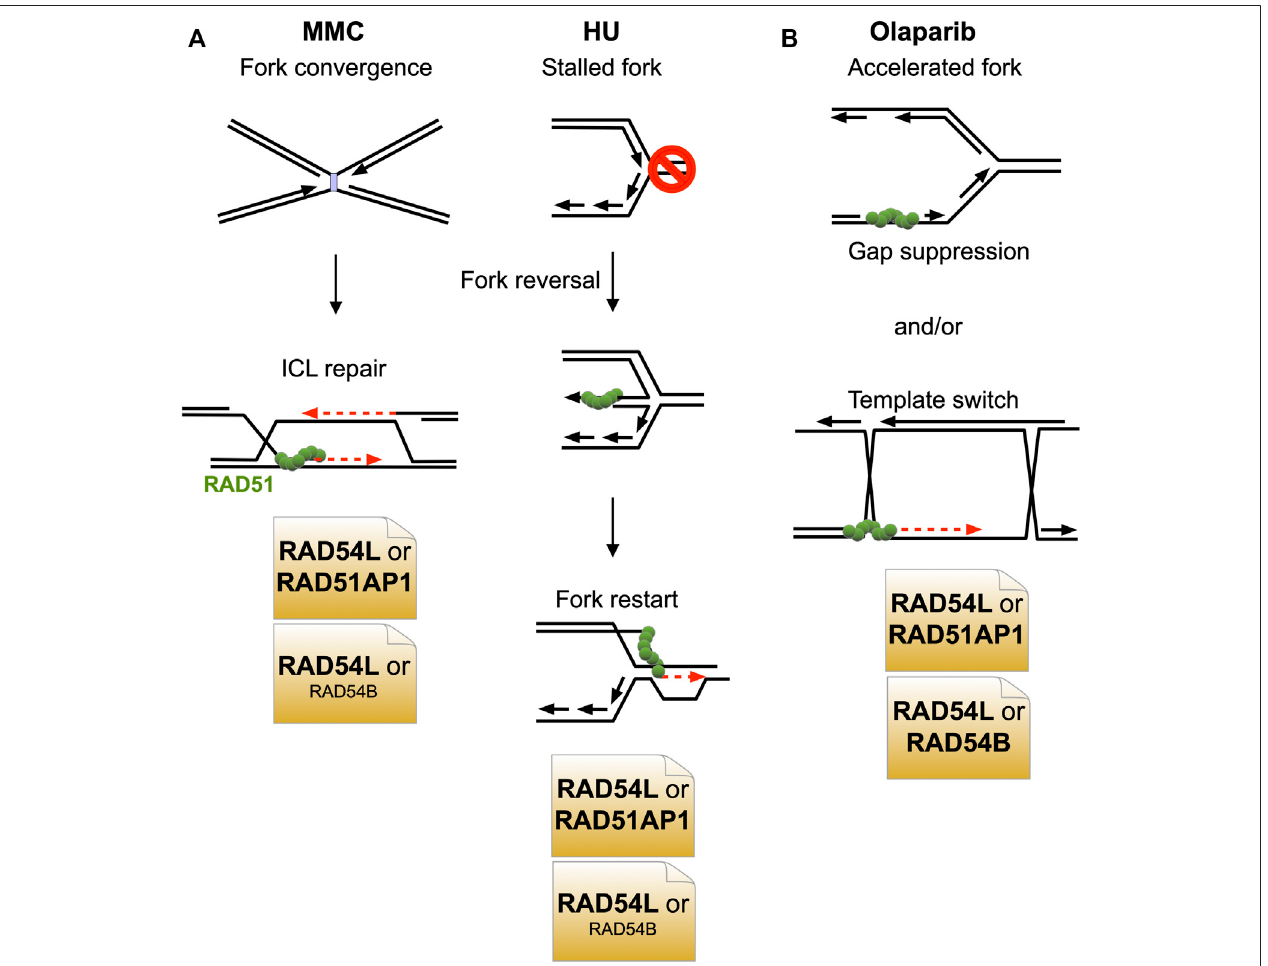
FIGURE 6 | Model depicting the predominant negative genetic interactions between RAD54L and RAD51AP1 and between RAD54L and RAD54B. (A) Upon treatment of cells with MMC or HU, RAD54L loss is compensated for more extensively by RAD51AP1 than by RAD54B. (B) Upon treatment of cells with olaparib, RAD51AP1 and RAD54B compensate for the loss of RAD54L to similar extent.